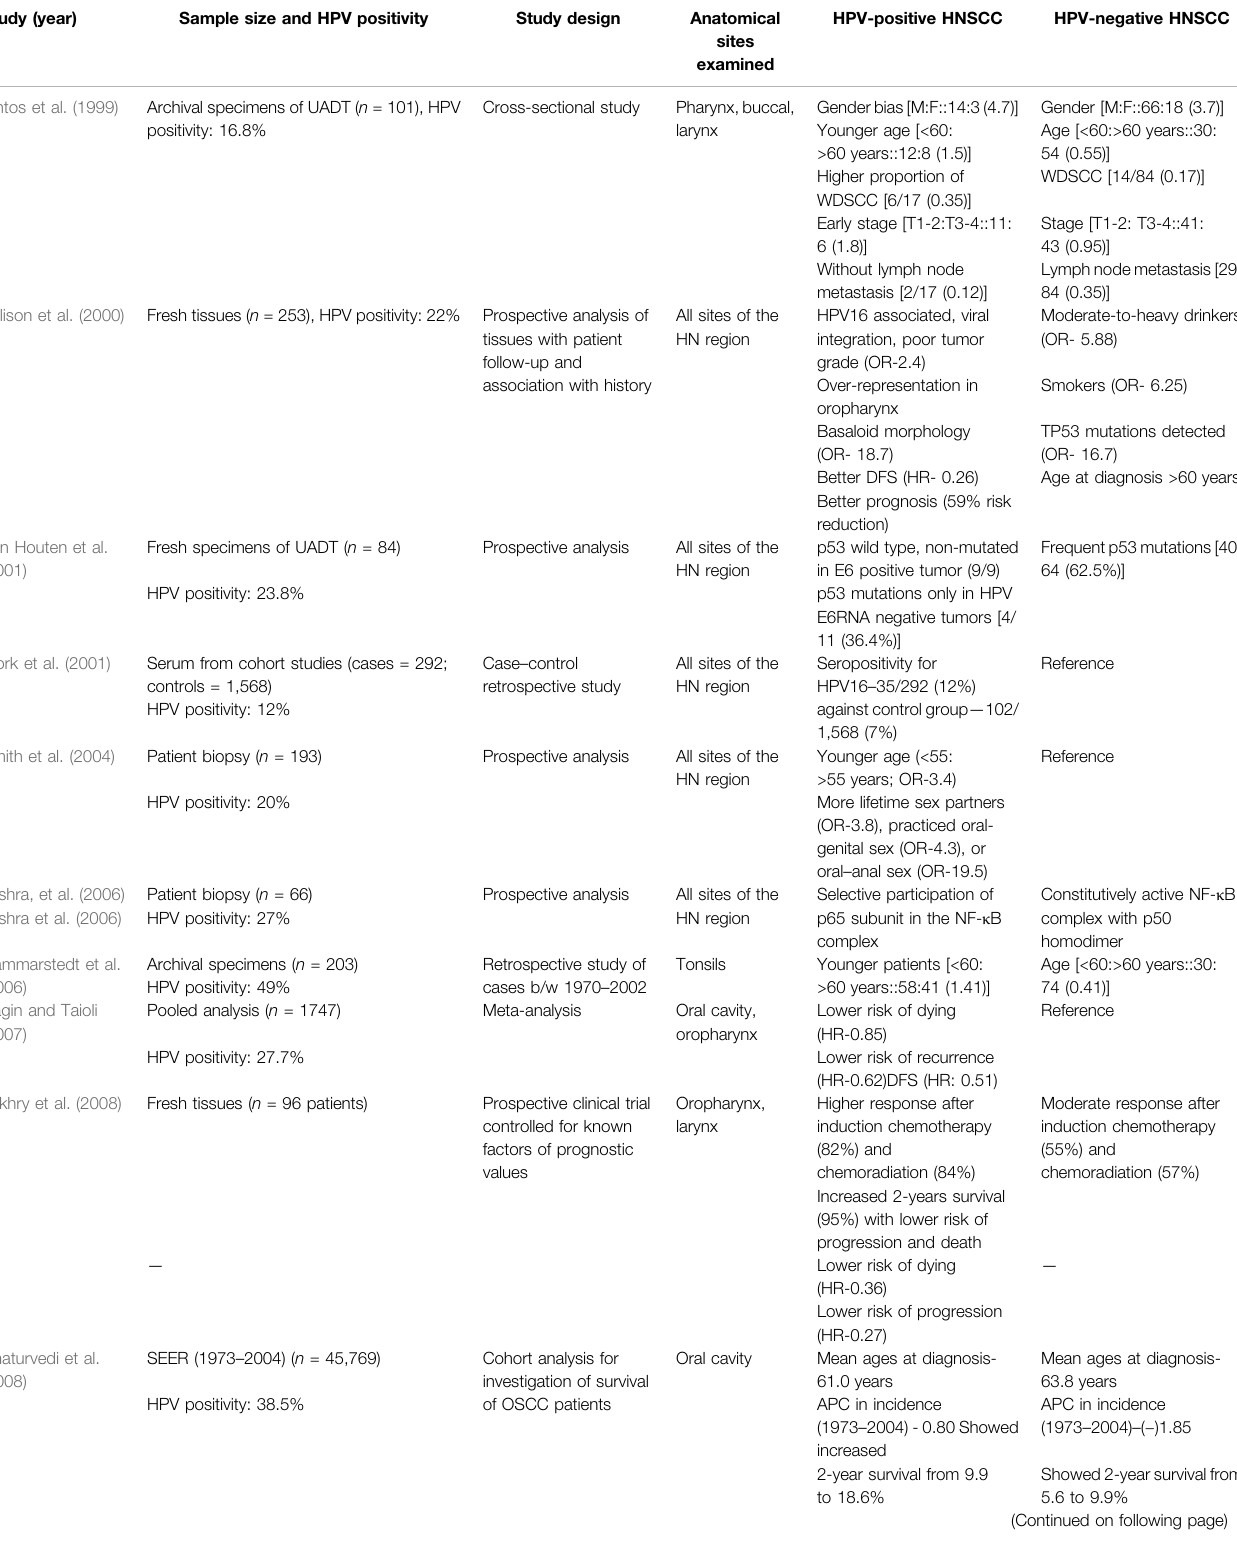
TABLE 2 | Representative studies demonstrating the existence of HPV-positive HNC as a distinct disease